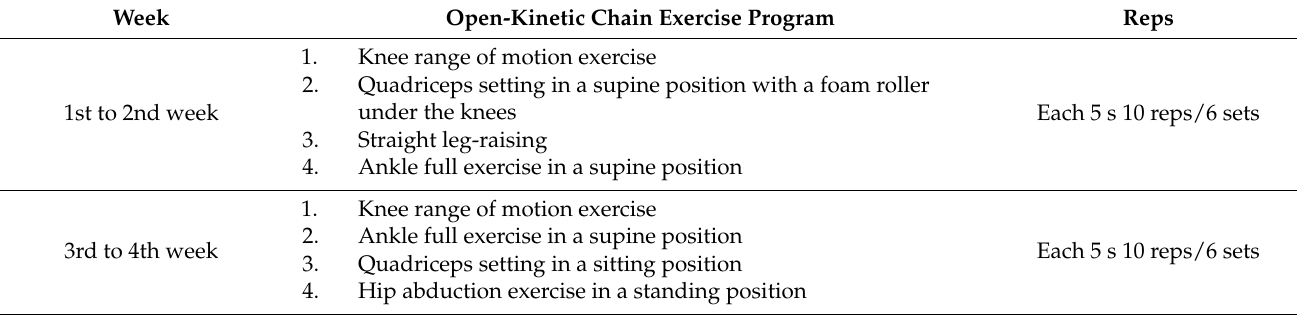
Table 2. Open kinetic chain exercise